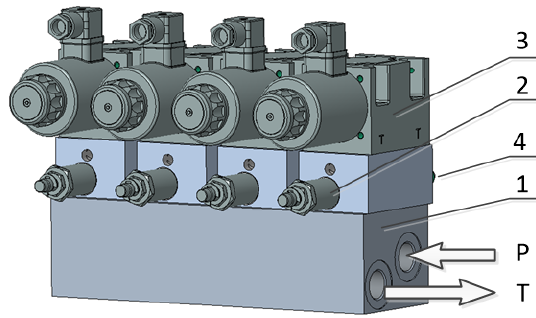
Figure 1. Scheme of the analyzed valve block: 1—connection plate; 2—flow control valve; 3—electromagnetic control valve; 4—relief valve; P, T—connection